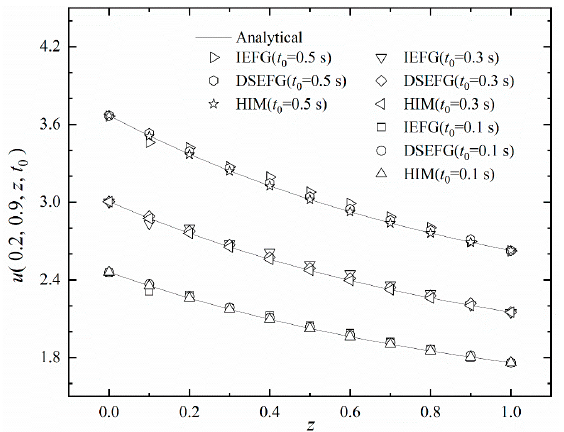
Figure 3. Calculation results along z -axis when t 0 is